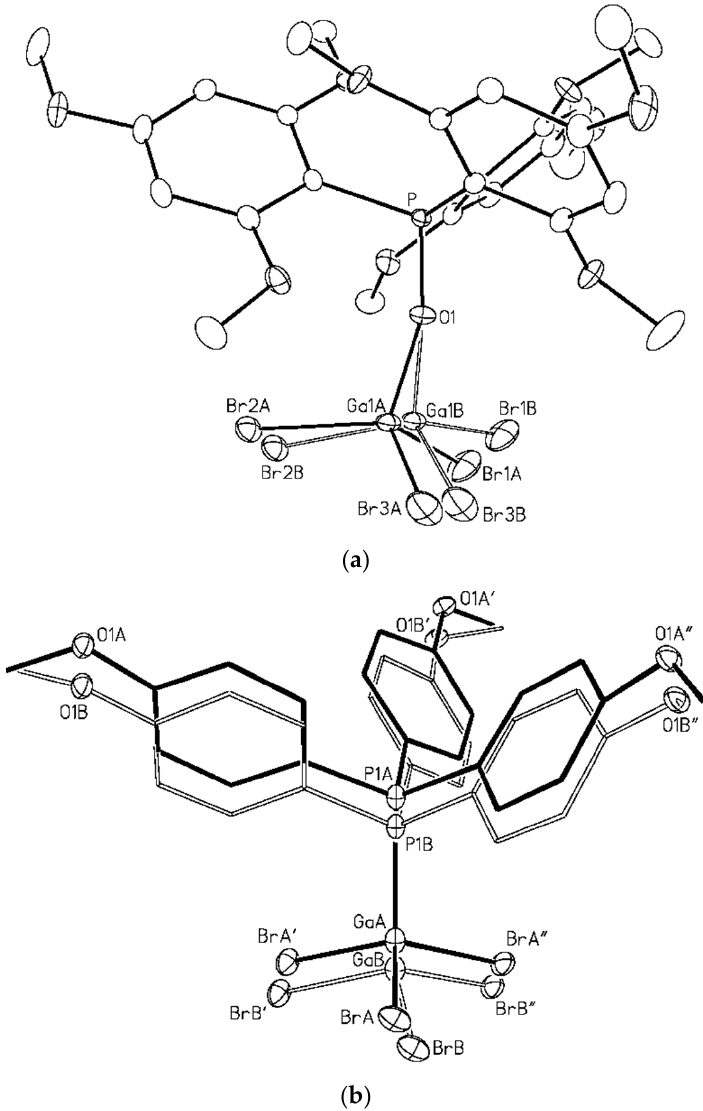
Figure 4. ( a ) View of complex 2 showing the relative positions of both the major and minor orienta- tions of the disordered GaBr 3 group. ( b ) Representation of the disordered mode of complex 2. Carbon atom thermal ellipsoids are not shown. Bonds within the major (90%) conformer (containing the atoms Br(A), Ga(A), P(1A), and O(1A)) are shown as solid lines; within the minor (10%) conformer (containing the atoms Br(B), Ga(B), P(1B), and O(1B)), bonds are represented by hollow lines. The conformers are separated by a translation of approximately 0.5 Å along the crystal z axis.